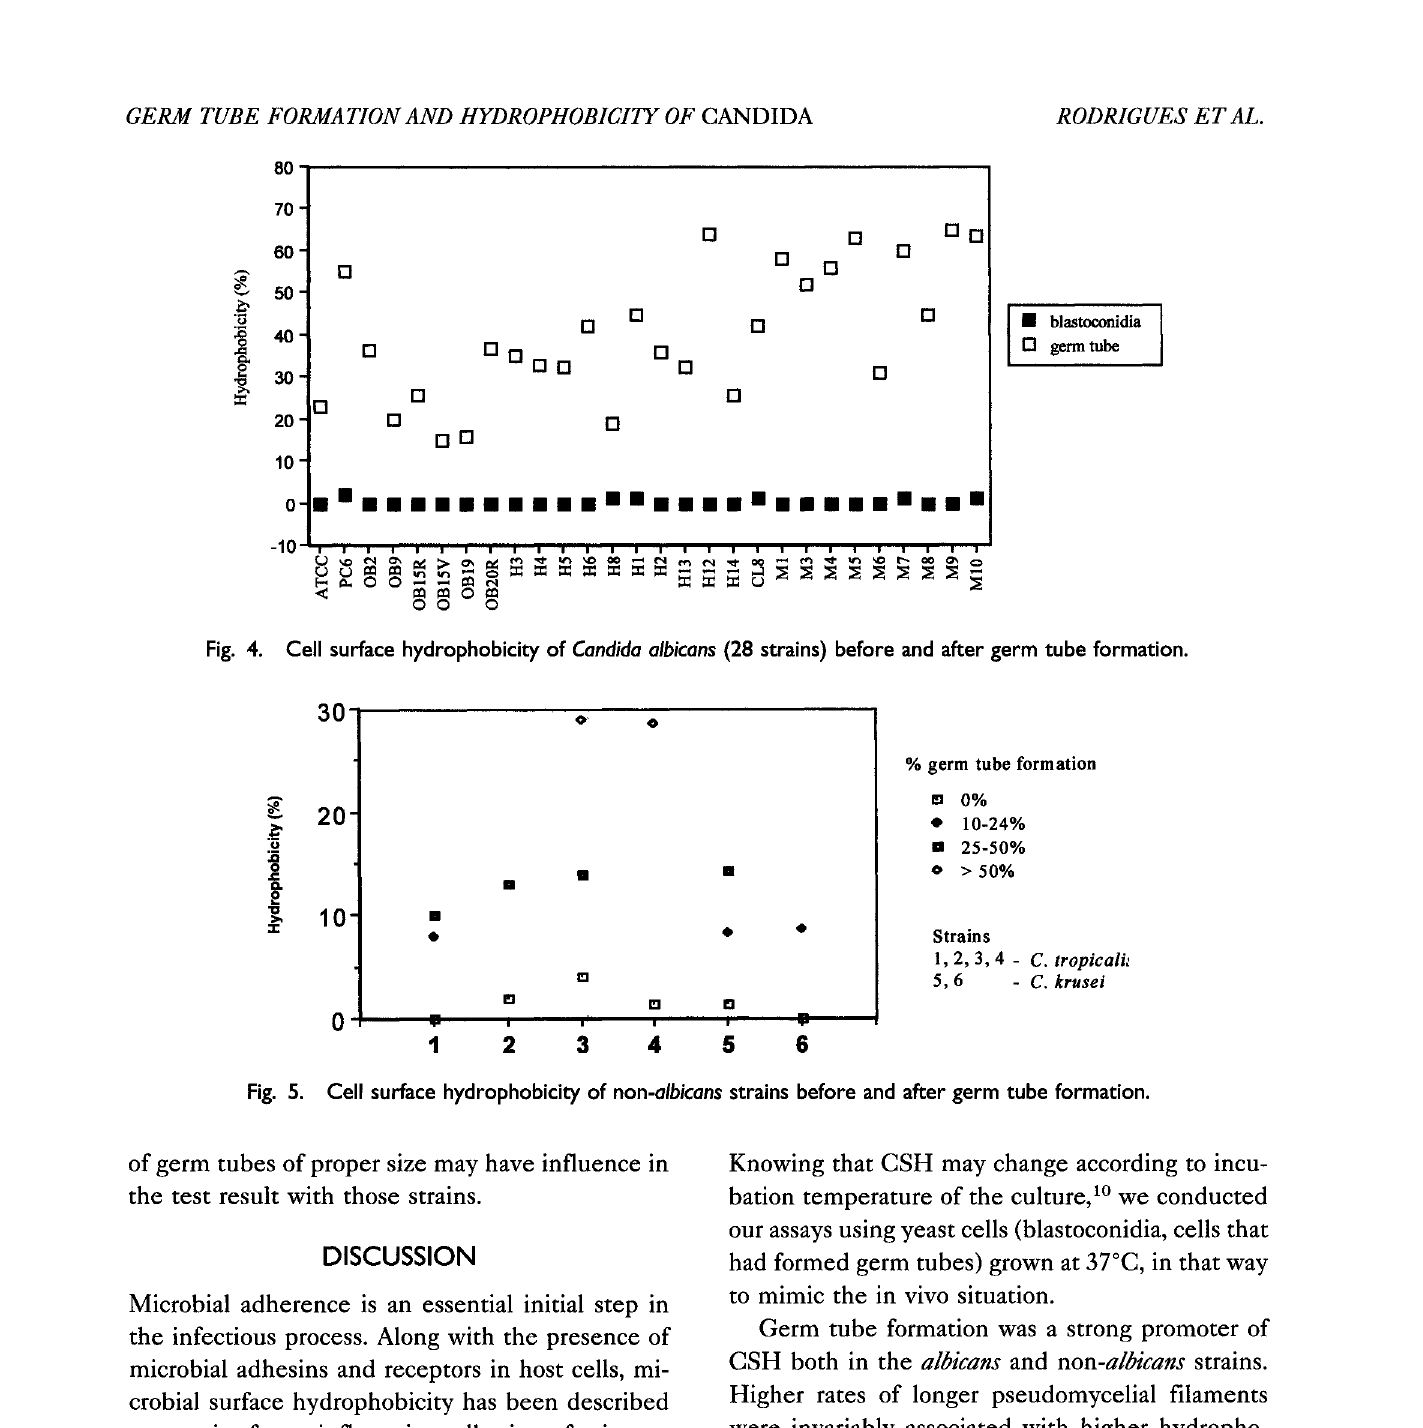
Fig. 5. Cell surface hydrophobicity of non-albicans strains before and after germ tube formation. of germ tubes of proper size may have influence in the test result with those